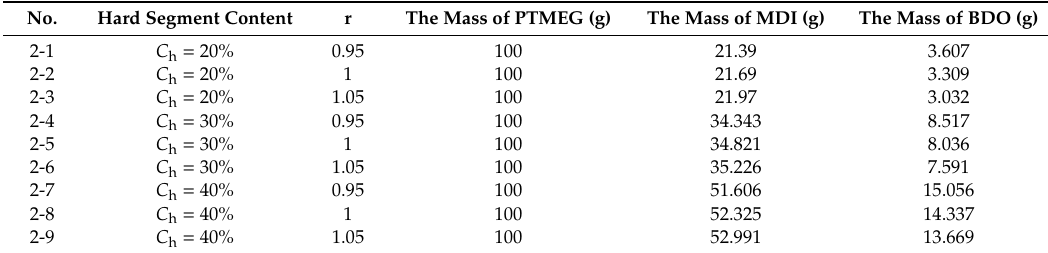
Table 2. Composition and hard segment content of polyether-based